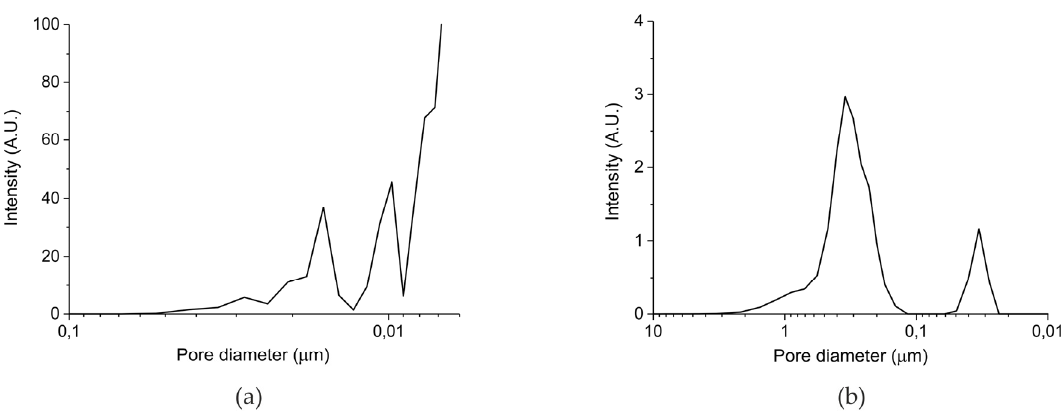
Figure 1. ( a ) Pore size distribution for sample B batch II and ( b ) pore size distribution for sample C batch III according Hg porosimetry.